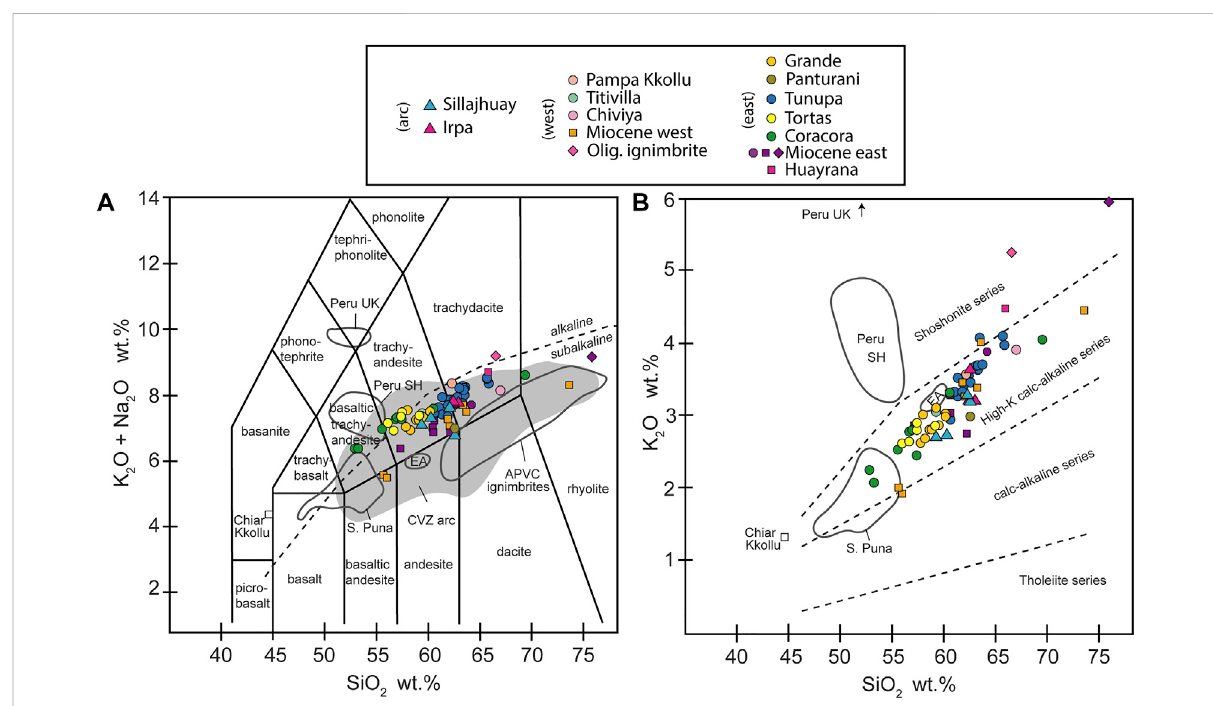
FIGURE 7 Whole-rock geochemical classi fi cation for the 50 samples analyzed in this study with examples of relevant plateau volcanism shown for reference. Samples of Tunupa volcano (Salisbury et al., 2015) are included in this diagram and show the range of compositions from a single composite center. (A) Total Alkali-Silica (TAS) diagram with classi fi cation from Le Maitre et al. (1989) and alkaline/subalkaline fi elds of Irvine and Baragar (1971). Solid grey fi eld shows the entire distribution of CVZ Quaternary arc lavas (Mamani et al., 2010). Chiar Kkollu (Hoke and Lamb, 2007) and grey outlines show distribution of comparative examples of reararc volcanism discussed in the text: ma fi c volcanic rocks of the southern Puna (Drew et al., 2009; Risse et al., 2013); shoshonitic (SH) and ultrapotassic (United Kingdom) reararc lavas from the northern Altiplano of Peru (Carlier et al., 2005); Quillacas volcano (EA) of the Bolivian eastern Altiplano (McLeod et al., 2012), and the ignimbrites of the Miocene to Pleistocene Altiplano-Puna volcanic complex (APVC; Salisbury et al., 2011). (B) Classi fi cation of samples using the SiO 2 vs K 2 O diagram (Irvine and Baragar, 1971; Peccerillo and Taylor, 1976). Distribution of reararc lavas from the literature are the same references as in (A) . Ultrapotassic lavas from the Peruvian northern Altiplano plot off the graph (wt% SiO 2 = 50 – 54%; wt% K 2 O = 7.0 –